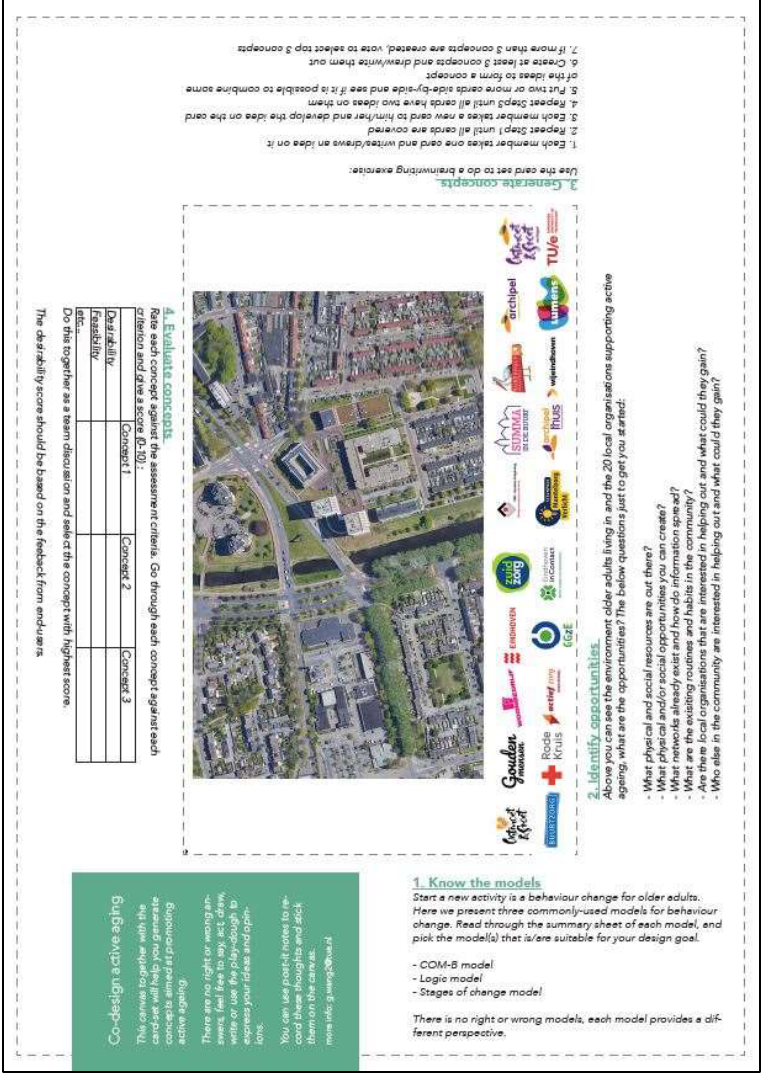
Figure 3. The canvas of the toolkit.